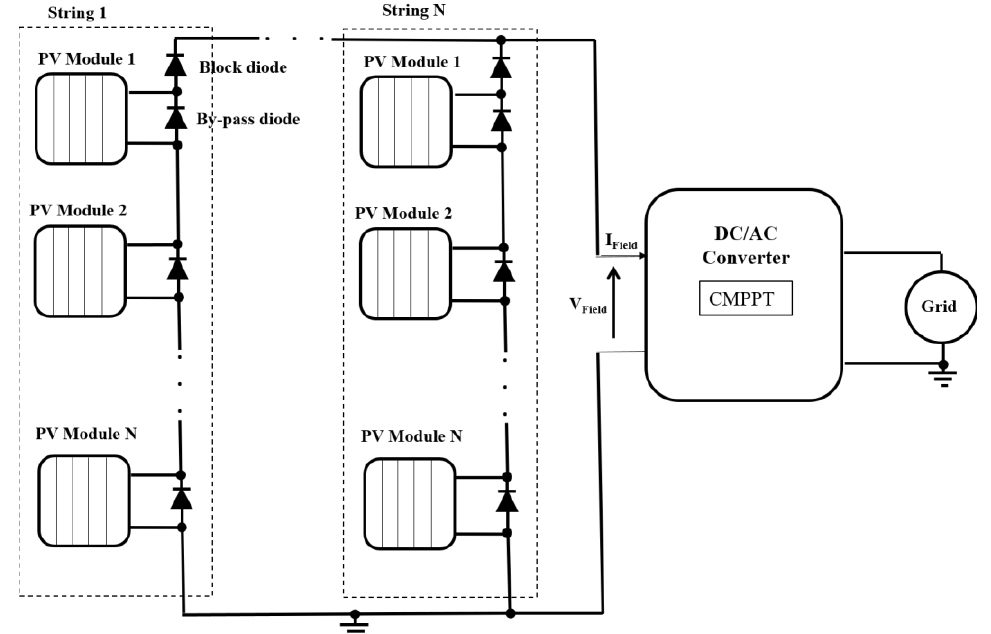
Figure 1. Central Maximum Power Point Tracking (CMPPT) architecture in grid-connected photovoltaic (PV) applications.